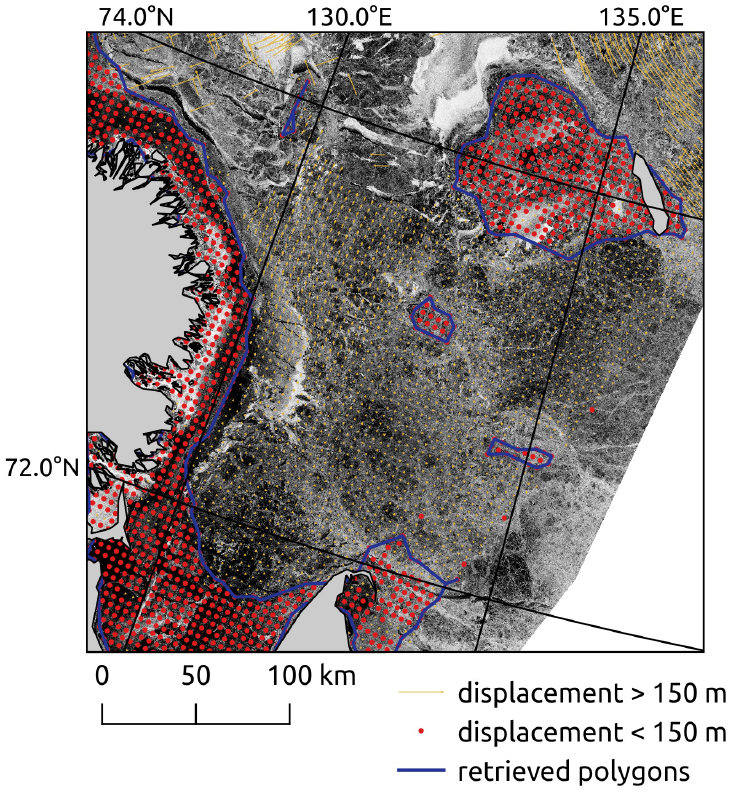
Figure 3. An example of methods steps output. The yellow arrows show the sea ice drift field calculated from the ENVISAT SAR image pair taken on 19 (the background image) and 22 December 2007 (step 1). The filtered near-zero displacement points are shown in red (step 2). The blue line shows the resultant fast ice polygons (step